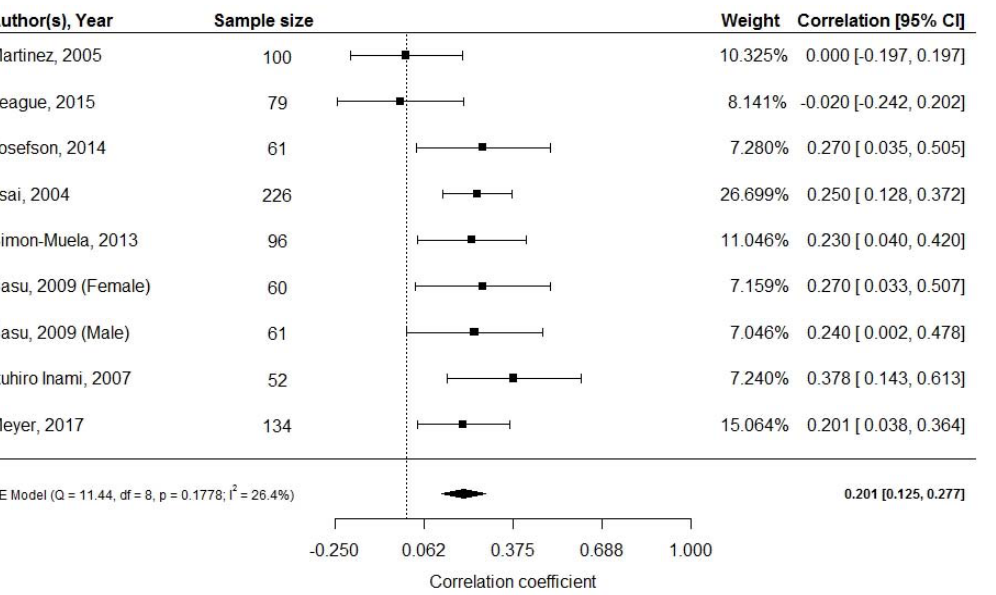
Figure 3. Cord blood adiponectin and fat mass at birth; df: degree of freedom, RE: random effects model.